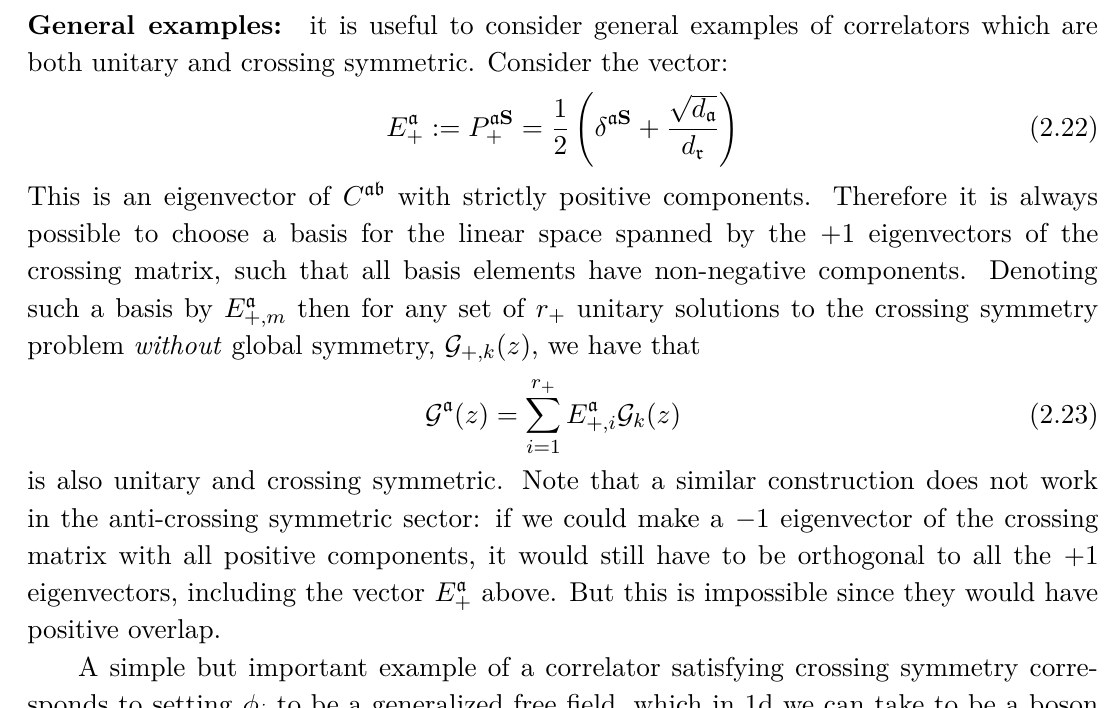
Figure 1 . Projections of G a ( z ) (violet) written as G ± ,s ( z ) = P symmetric (blue) and crossing anti-symmetric vectors